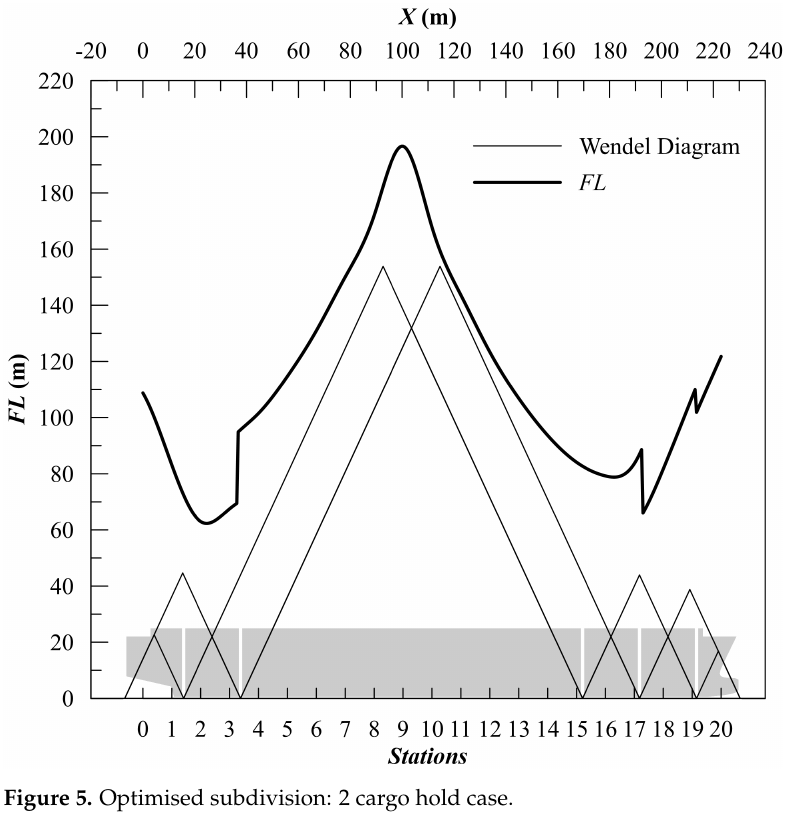
Figure 5. Optimised subdivision: 2 cargo hold case.